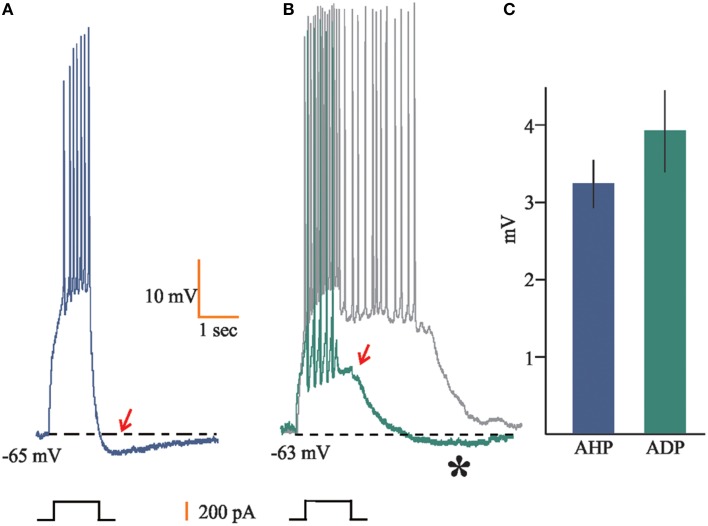
Afterpotentials in accessory olfactory bulb (AOB) neurons. (A) 42% of the neurons recorded (n = 39) displayed after hyperpolarization (AHP) (arrow) upon depolarizing current steps, (B) whereas seven and nine cells (17% in total) showed after depolarization (ADP) (arrow) or persistent firing (gray trace), respectively. Some cells (n = 6) also displayed slowly activating AHP following the ADP (asterisk). (C) Mean ± SEM of voltage displacements for AHP and ADP population values.